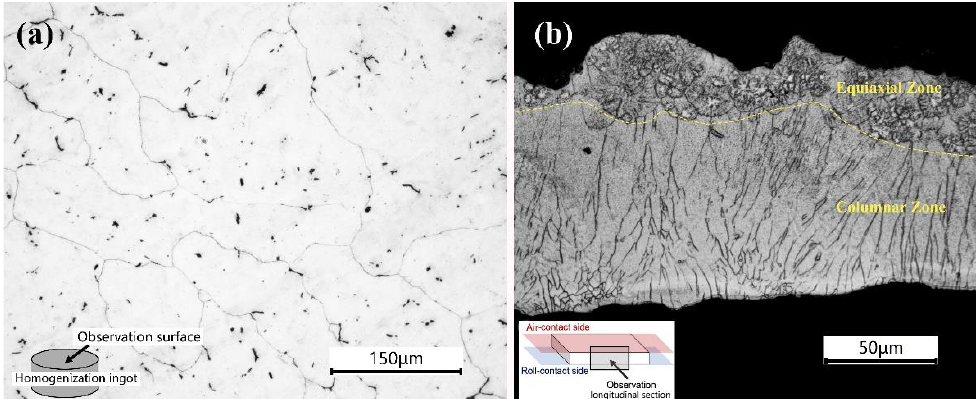
Figure 1. Optical microstructure of ( a ) AZ31 homogenized ingot (as-homogenized) and ( b ) longitudinal section of RS AZ31 ribbons (as-RS).